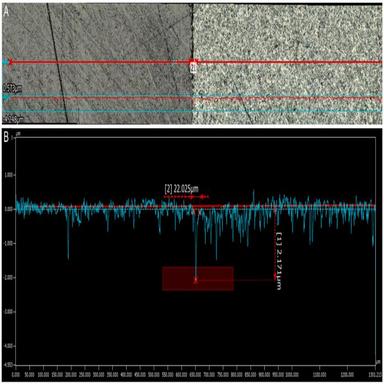
Surface analysis of the interface region between the embedding matrices and the uranium samples. Depth profiles for EPOFIX (A) and clay (C) embedding methods are shown in (B) and (D) respectively. The narrow and shallow interface gap for EPOFIX contrasts with the wide (>200 µm) and deep (>100 µm) gap for clay, leading to contributions of the sample lateral walls to the image shoulder of intensity profiles.